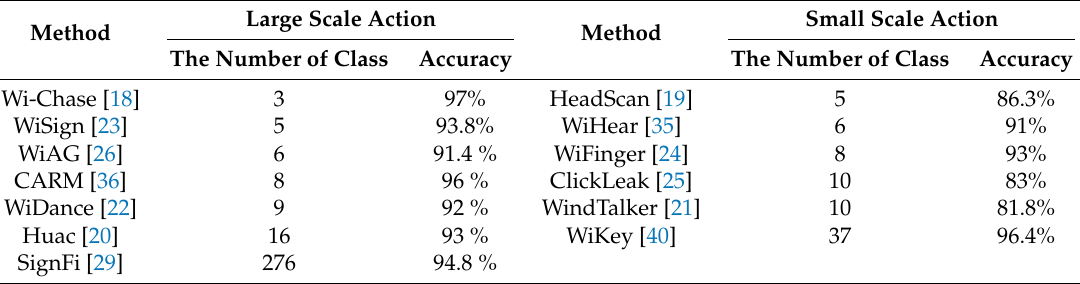
Table 1. Comparison of Motion Recognition Technologies using